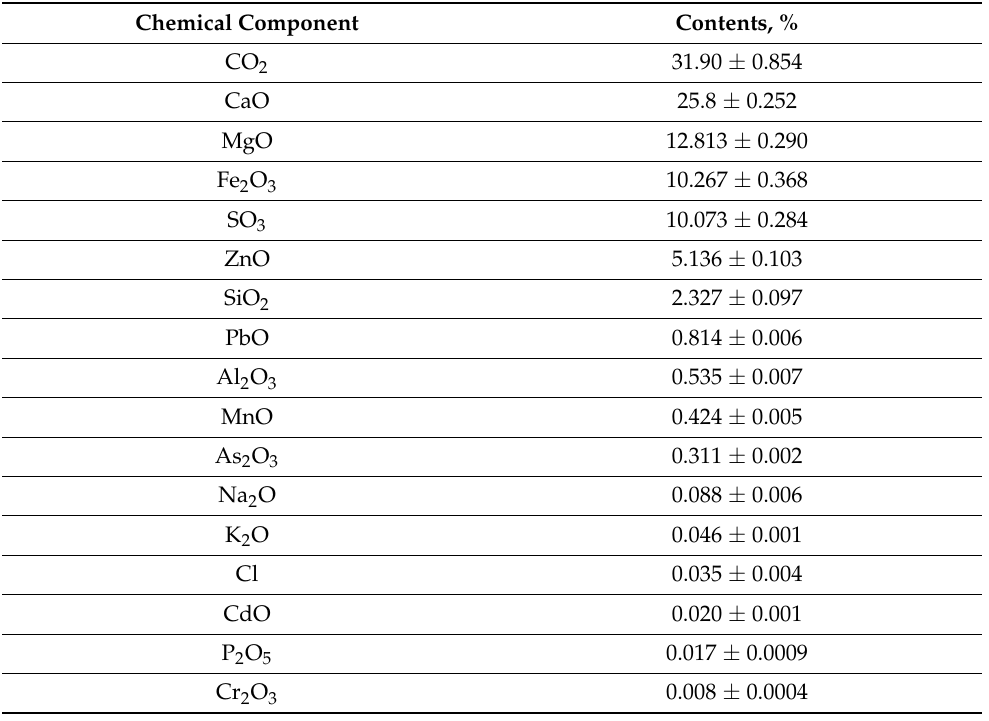
Table 1. Chemical composition of waste dolomite.